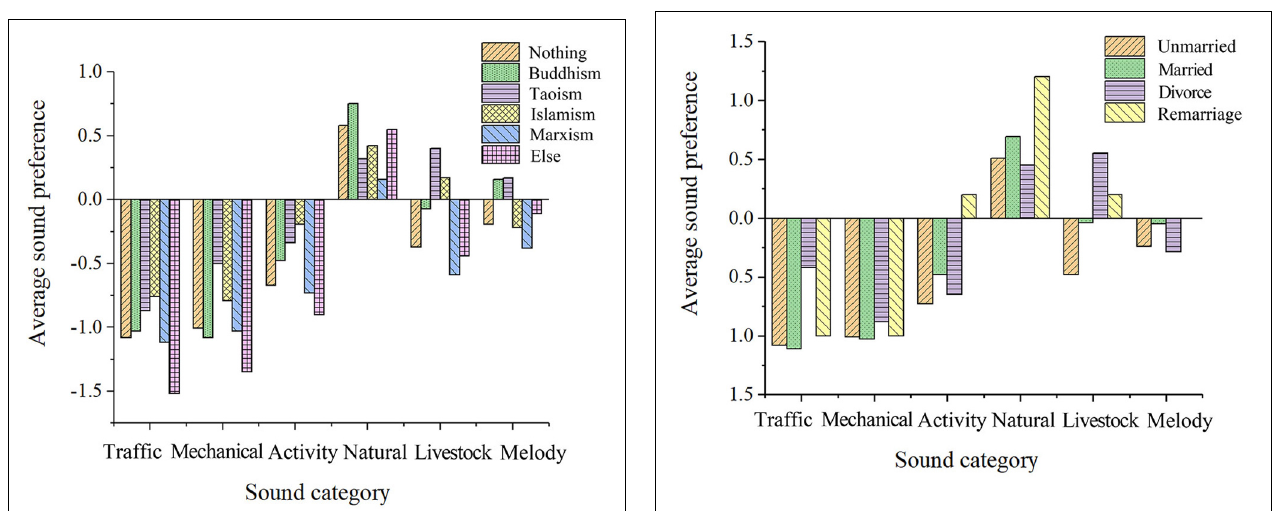
FIGURE 10 | Mean value of soundscape preference of different marriage